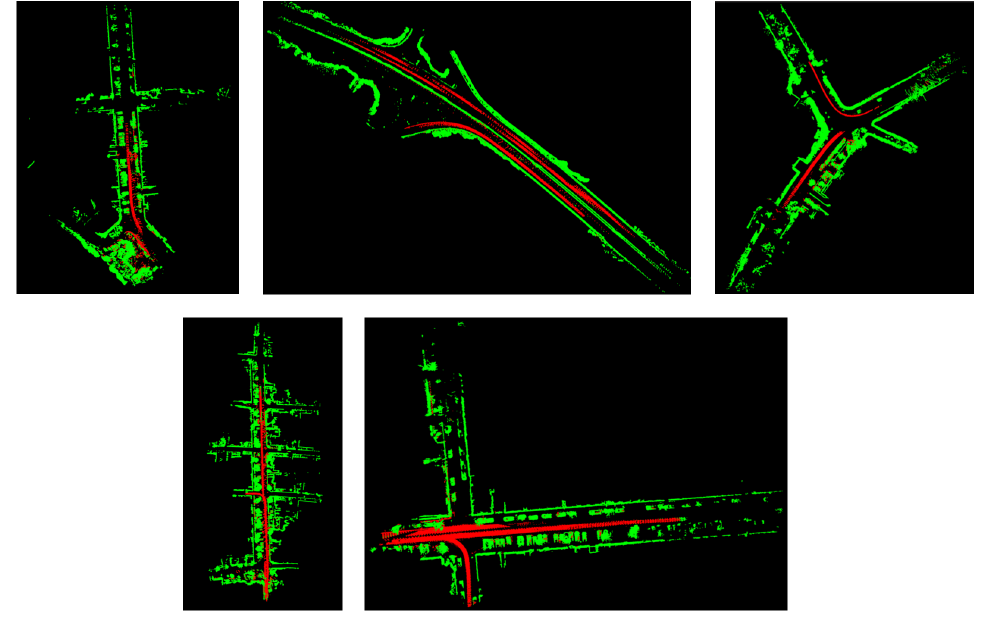
Figure 9. The map cleaning results for the five sequences (00, 01, 02, 05, and 07) in the Se- manticKITTI dataset. The identified moving points are colored in red, and the static points are colored in